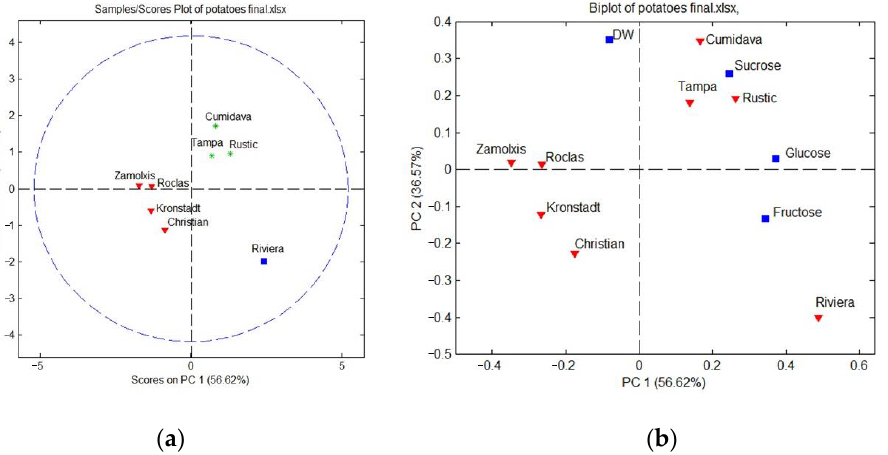
Figure 2. PCA scores ( a ) and biplot ( b ) for potato samples.